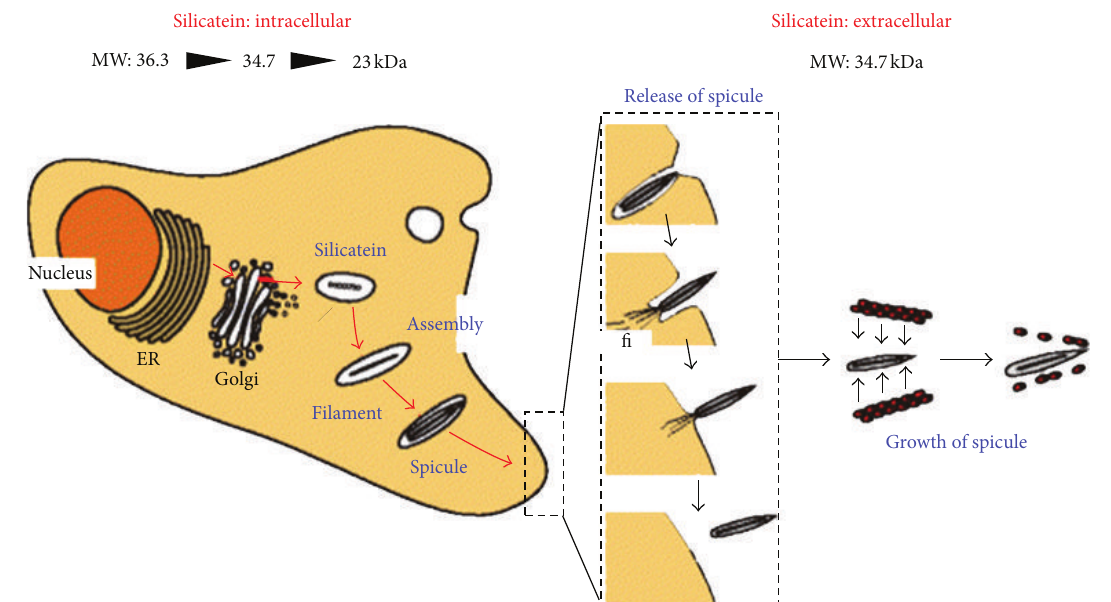
F 9: Model of spicule formation in S. domuncula is starts intracellularly by processing of silicatein to a mature and phosphorylated 23-kDa form, which assembles to axial �laments and starts to template silica deposition around itself. e spicules are extruded from the cells and mature in size in the extracellular stage with the help of the 34.7kDa prosilicatein (lacking the signal peptide). No mature silicatein has so far been identi�ed outside the cell. �eproduced with permission from